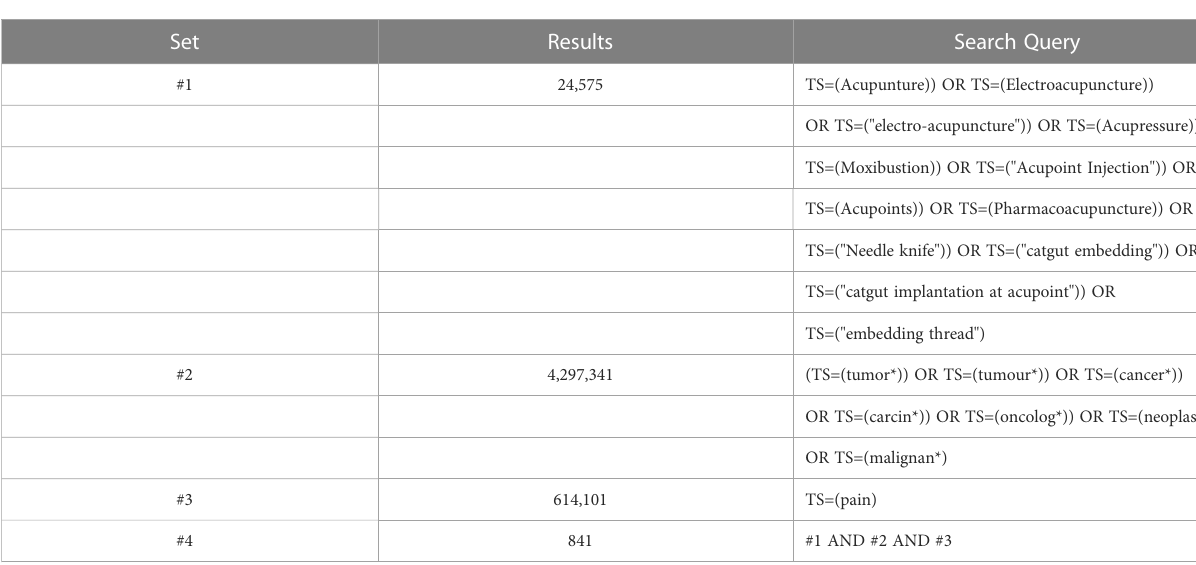
TABLE 1 The Topic Search